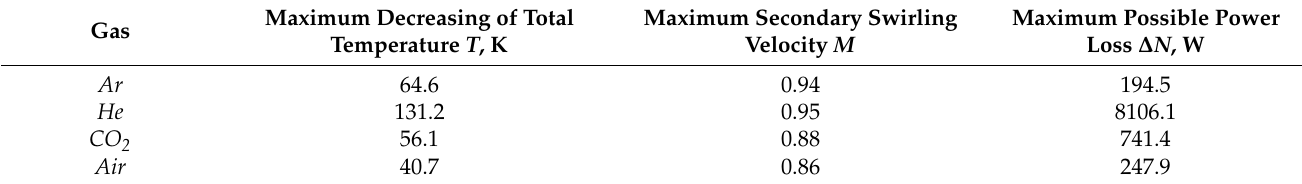
Table 9. SVT efficiency with the same Reynolds number.